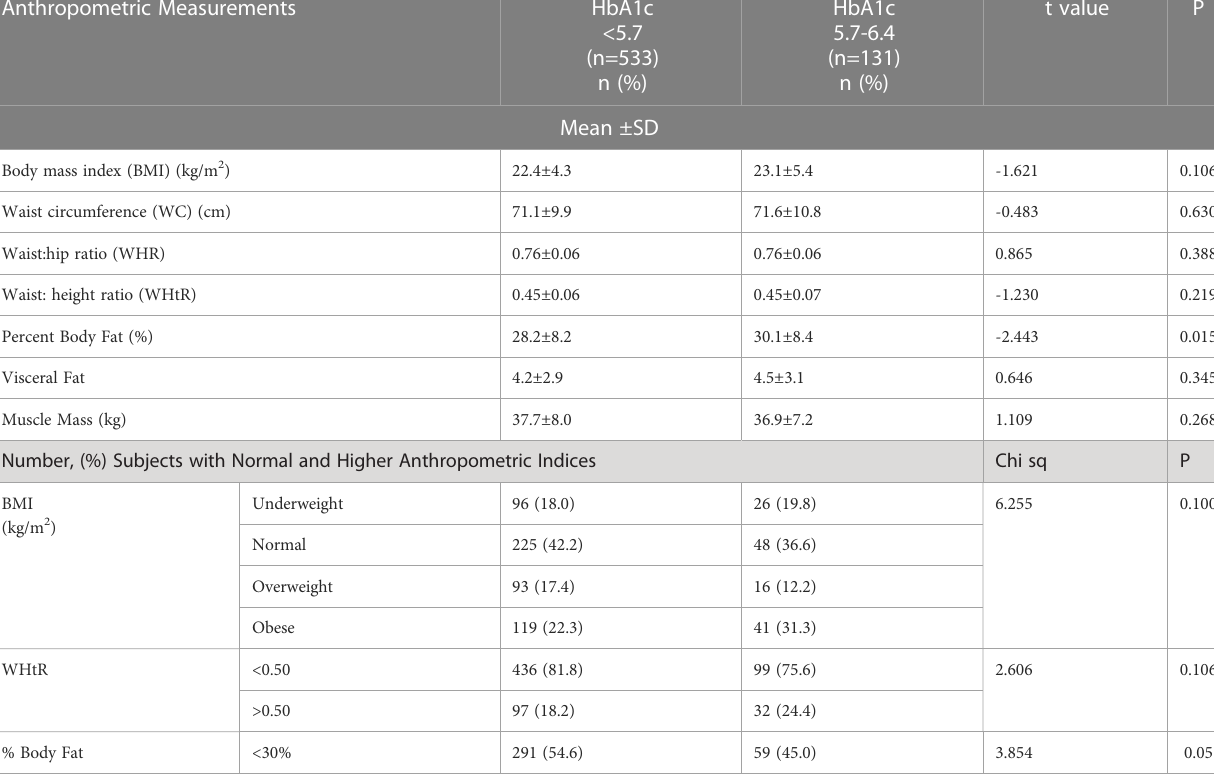
TABLE 2 Comparison of anthropometric indicators in participants with normal HbA1c (<5.7) and prediabetics (HbA1c: 5.7- 6.4).